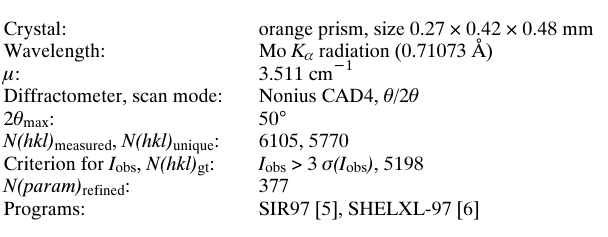
Table 1. Data collection and